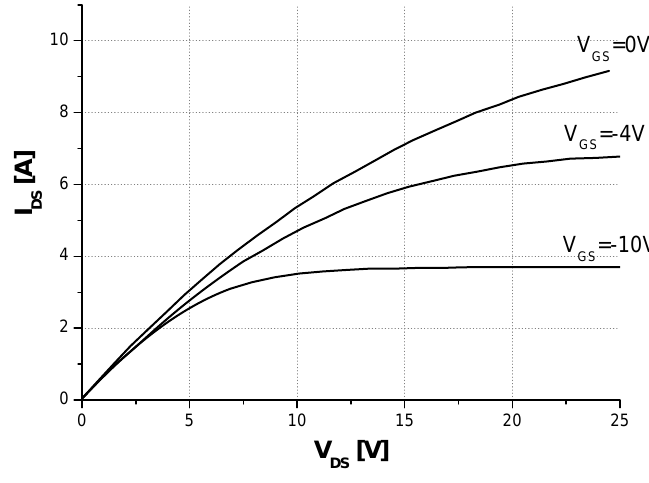
Figure 8. Experimental drain-current versus drain voltage characteristics as a Vgs parameter at 500 K of the 15 A-1,200 V SiC-JFET sample.